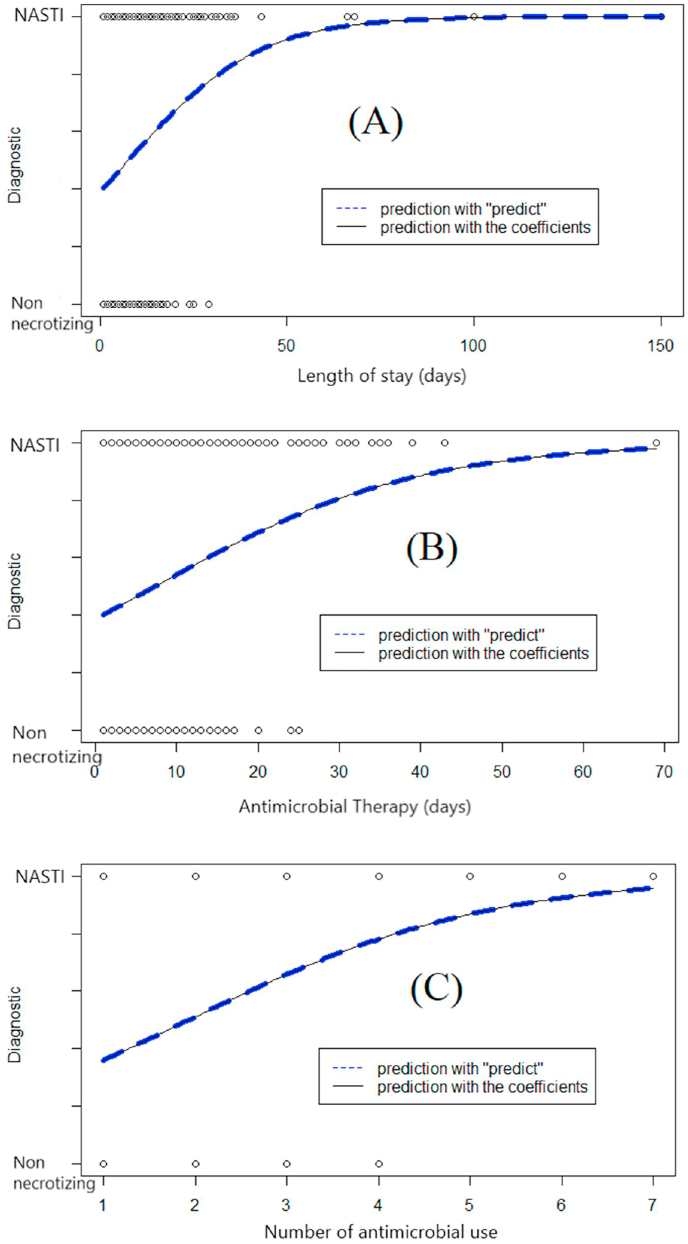
Tendency of continuous variables between the groups with non-necrotizing and necrotizing skin and soft tissue infection (SSTI). (A) Curve inclination for longer duration in necrotizing SSTI (NSTI); (B) inclination through longer duration of antimicrobial therapy in patients with NSTI; and (C) Tendency to use more antimicrobials in NSTI.